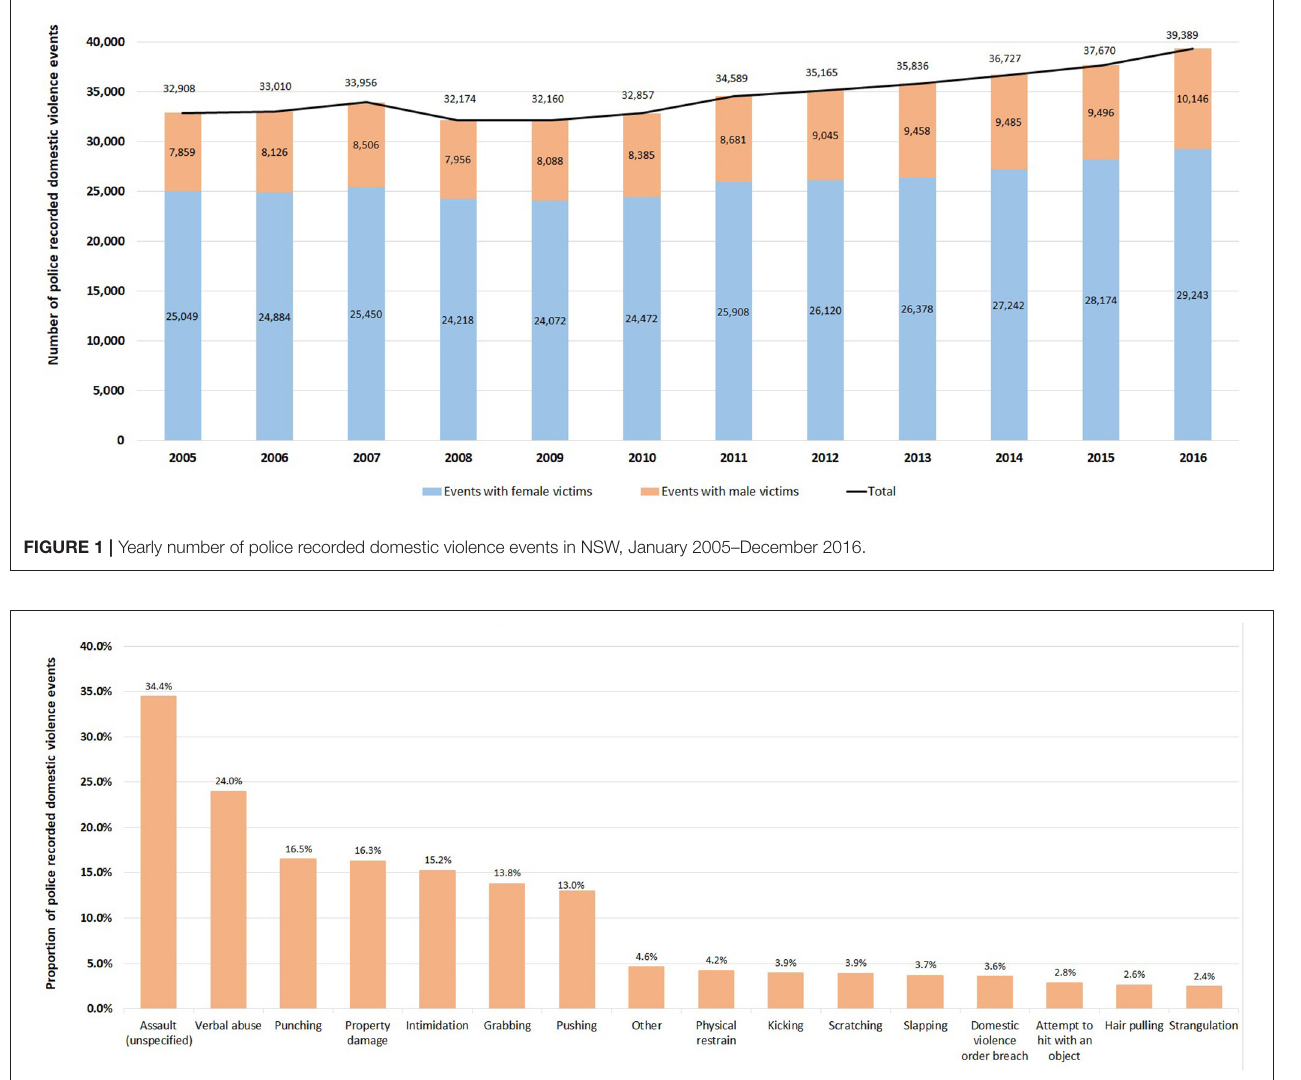
FIGURE 2 | Proportion of abuse types in 353,161 police recorded domestic violence events that occurred in residential premises in NSW, January 2005–December 2016.